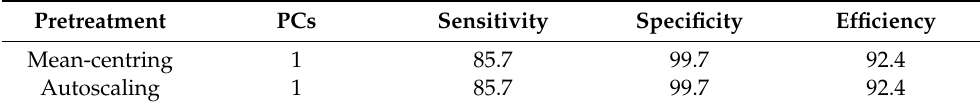
Table 3. SIMCA analysis of Class PDO Ricotta Romana.